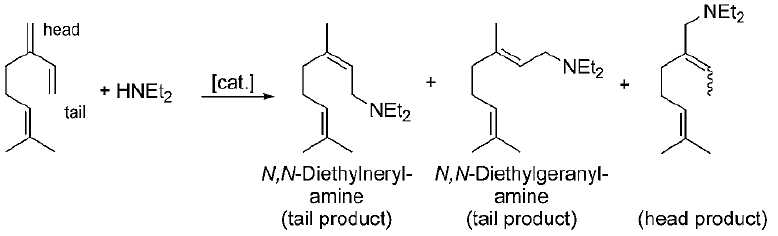
Figure 16. Identification of tail products in hydroamination of myrcene. Reproduced from [33] with permission from Willey.